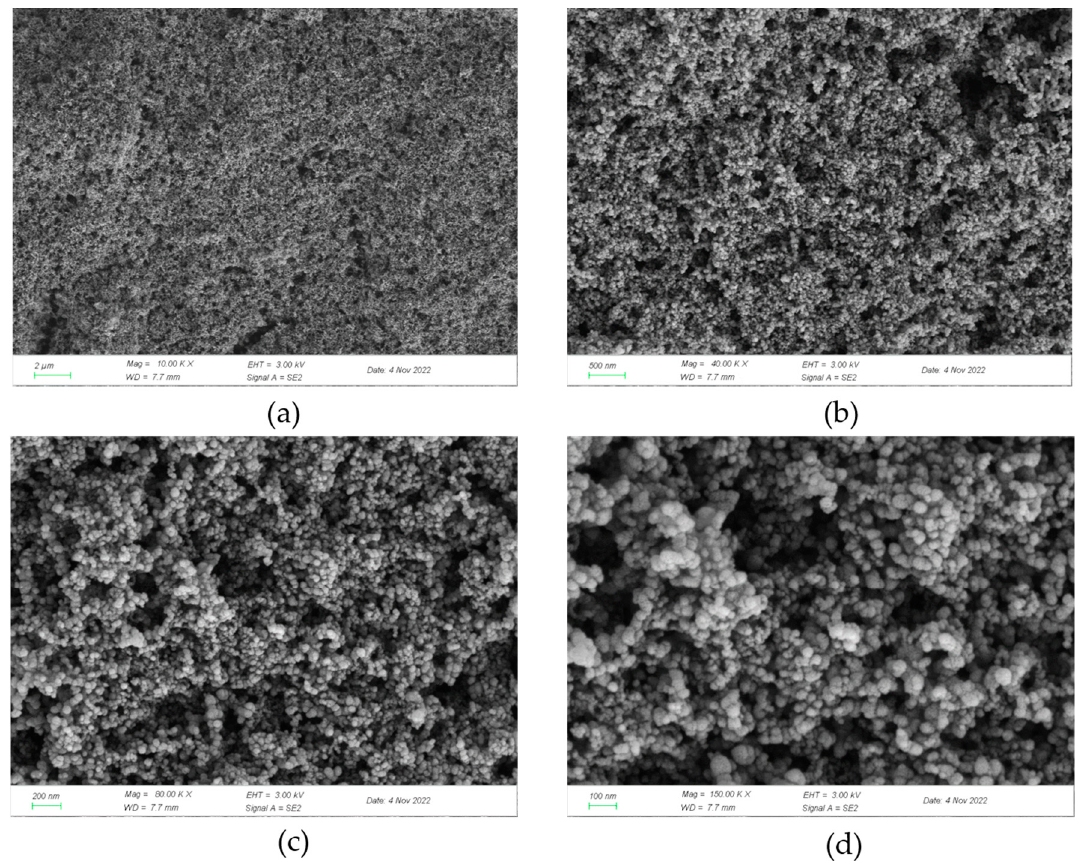
Figure 6. SEM micrographs of the GDI PM based on CLTC. ( a ) 2 μ m; ( b ) 500 nm; ( c ) 200 nm; ( d ) 100 nm. ( d ) 100